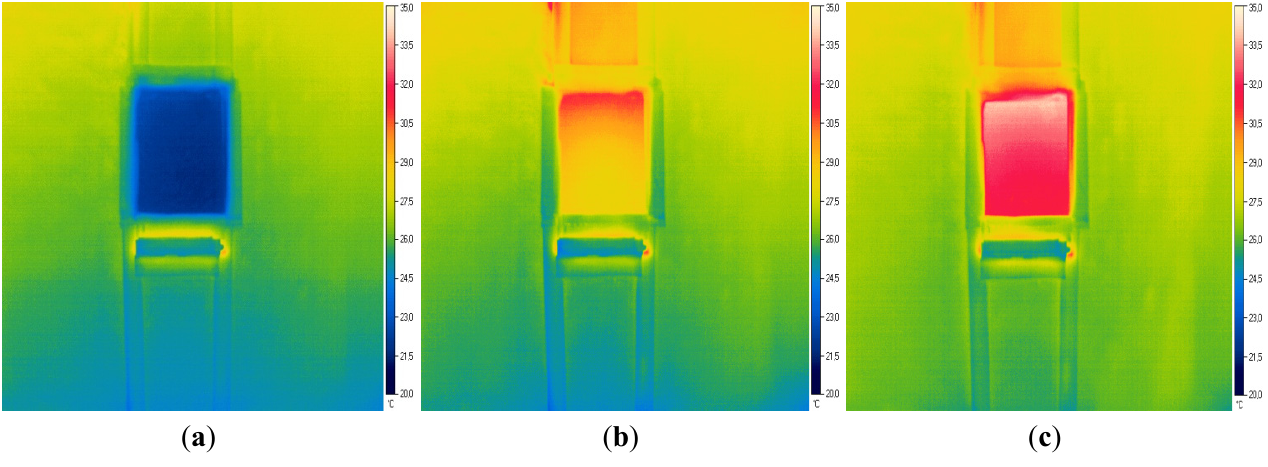
Figure 2. ( a ) A1 specimen thermography at t = 0, with T = 21.82 °C; ( b ) A1 specimen thermography at t = 90 min; ( c ) A1 specimen final thermography at the end with T = 32.6